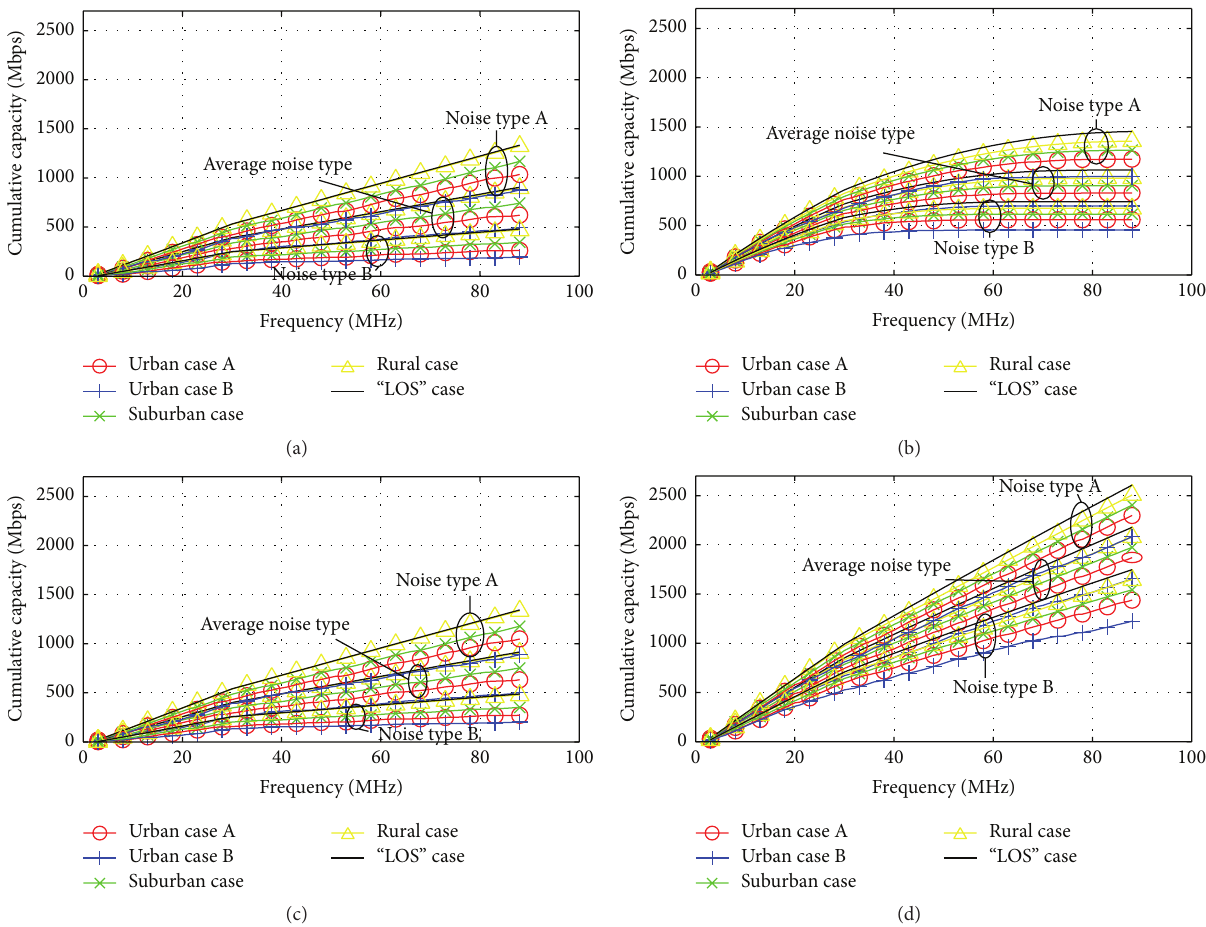
Figure 3: Cumulative capacity versus frequency of the indicative topologies of distribution BPL networks in the 3–88 MHz frequency band whenWtG 1 / StP 1 couplingschemesaredeployedandFCCPart15isadopted.NoisetypeA,averagenoisetype,andnoisetypeBareconsidered. (a) OV MV / WtG 1 . (b) UN MV / StP 1 . (c) OV LV / WtG 1 . (d) UN LV / StP 1